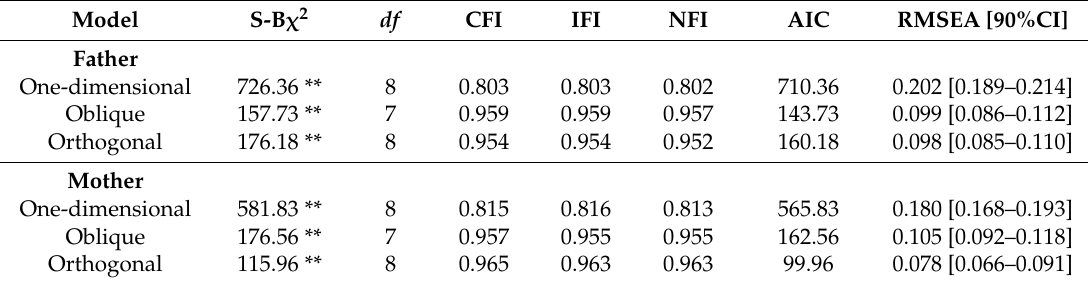
Table 2. Confirmatory factor analysis of fathers’ and mothers’ parenting